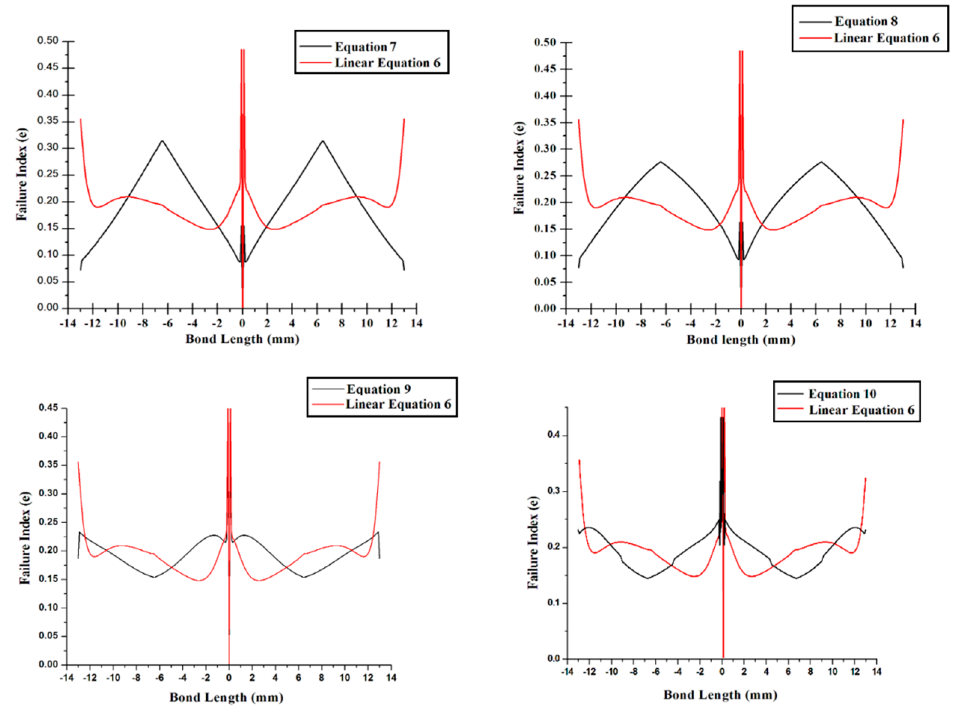
Figure 7. Variation in the breakdown index throughout the bond length for Equations